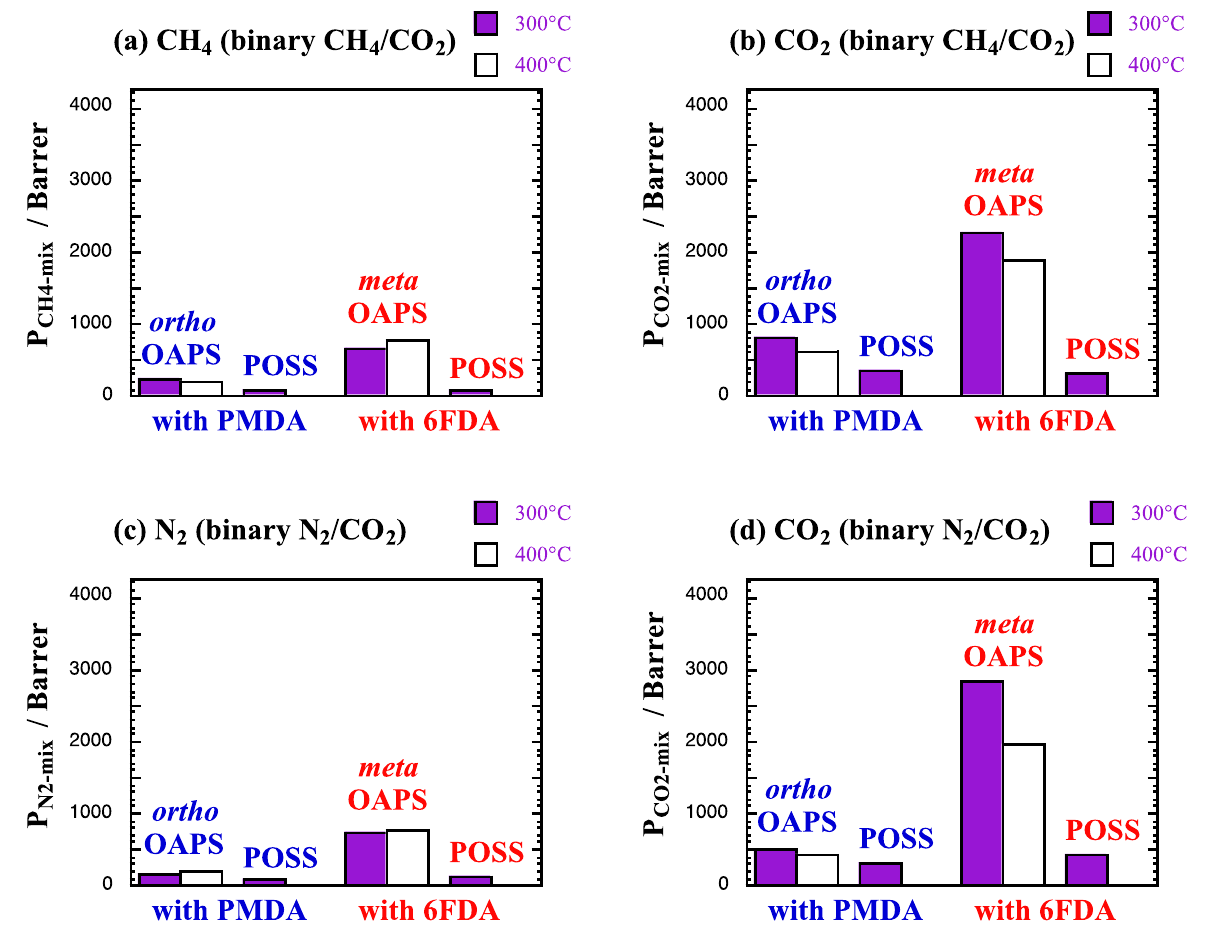
Figure 12. Mixed-gas permeability coefficients P gas-mix at 300 °C and 400 °C in the selected polyOAPS/POSS-imides for ( a , b ) CH 4 and CO 2 from the 90%/10% CH 4 /CO 2 mixture and ( c , d ) N 2 and CO 2 from the 90%/10% N 2 /CO 2 mixture at 60 bar. The scale is 25% of that in Figure 7. The maximum standard error is 55 Barrer for CH 4 and N 2 and 125 Barrer for CO 2 .